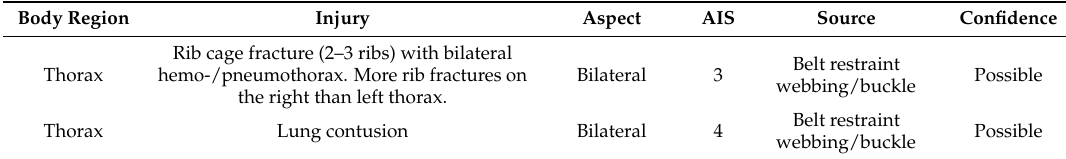
Belt restraint Bilateral 3 Possible webbing/buckle Belt restraint webbing/buckle